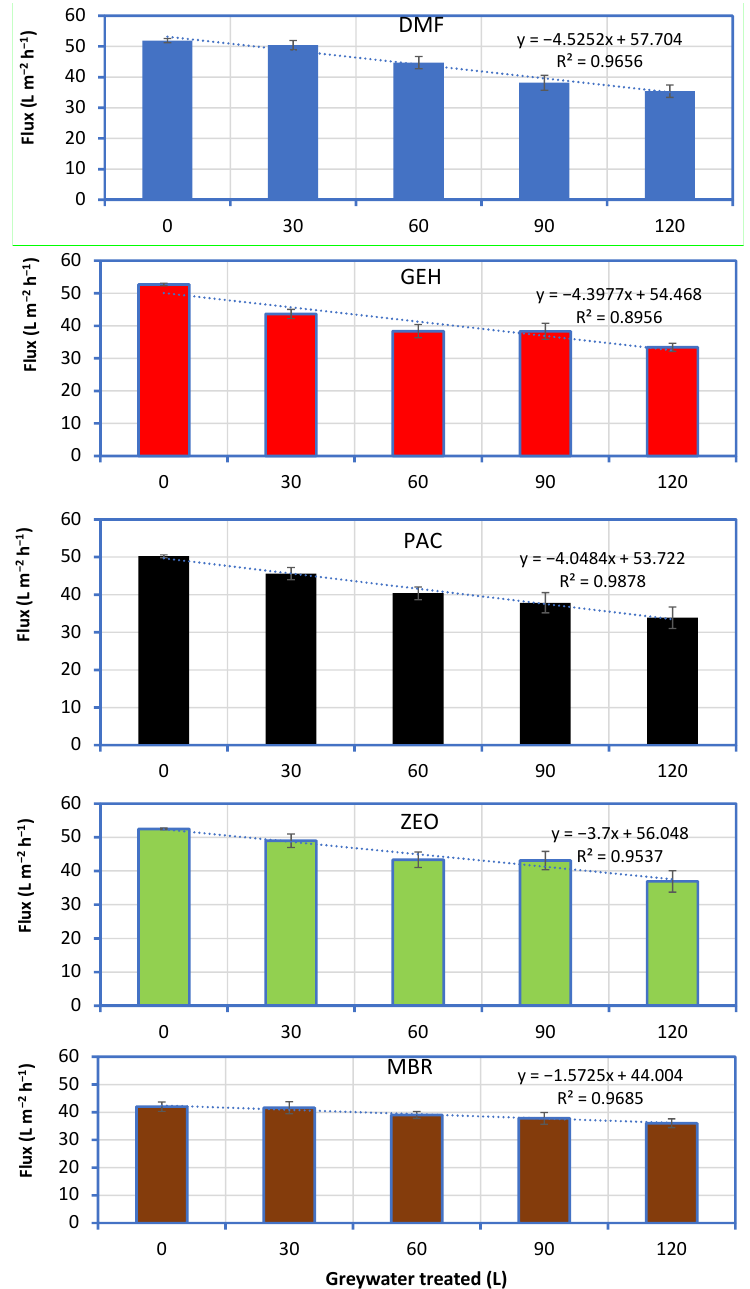
Figure 3. Normalized permeate flux as a function of greywater volume treated during short-term operation of a membrane reactor with different additives, treating synthetic greywater (DMF: Direct membrane filtration; PAC: Powder activated carbon; ZEO: Powder zeolite; GEH: Powder iron hydroxide; MBR: Activated sludge).